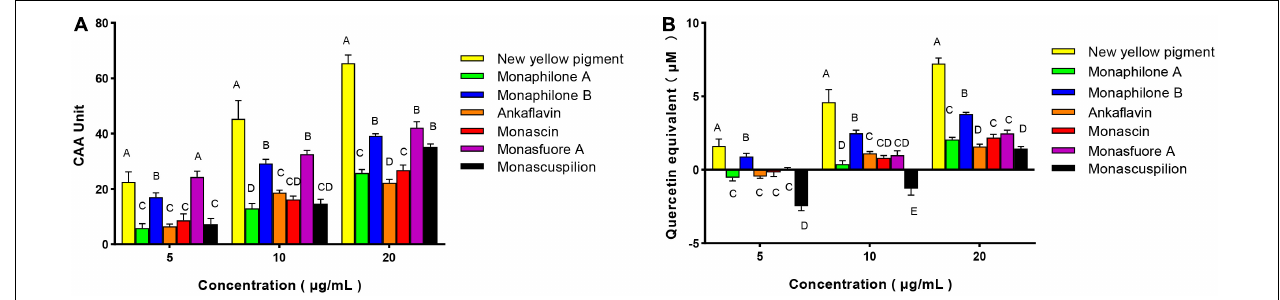
FIGURE 8 | Cellular antioxidant activity (CAA) of Monascus yellow pigment from functional Qu (FQ) and coloring Qu (CQ) and quercetin equivalent in Caco-2 cells. (A) Cellular antioxidant activity value. (B) Quercetin equivalent.